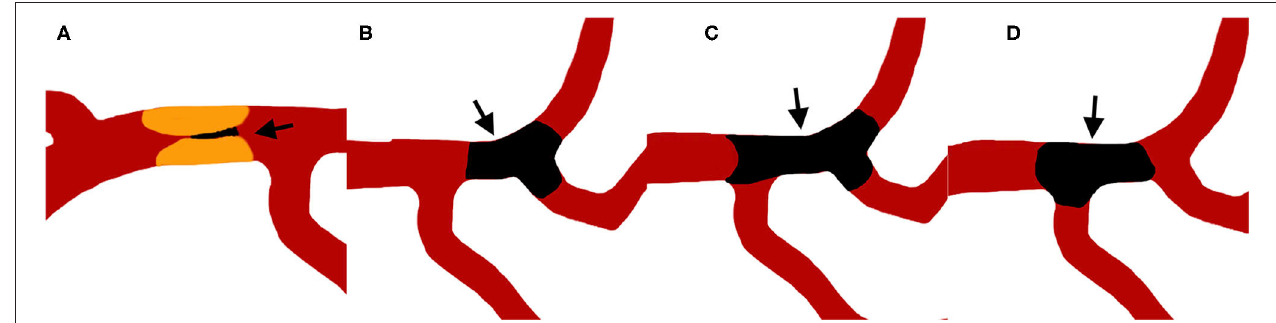
FIGURE 1 | Illustration of jet-like appearance and non-jet-like appearance, arrows point to the thrombus. (A) shows a typical jet-like appearance of intracranial artery stenotic occlusion. (B–D) shows non-jet-like appearance of embolic occlusion with flat (B) , convex (C) , and concave (D) appearance at the proximal edge of the occluded